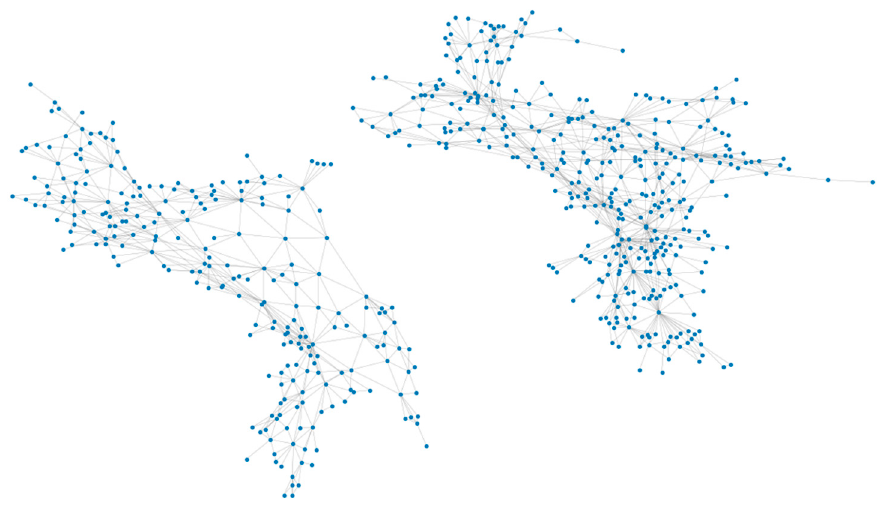
Figure 11. Location of the sample region for building the graph of Kent County.